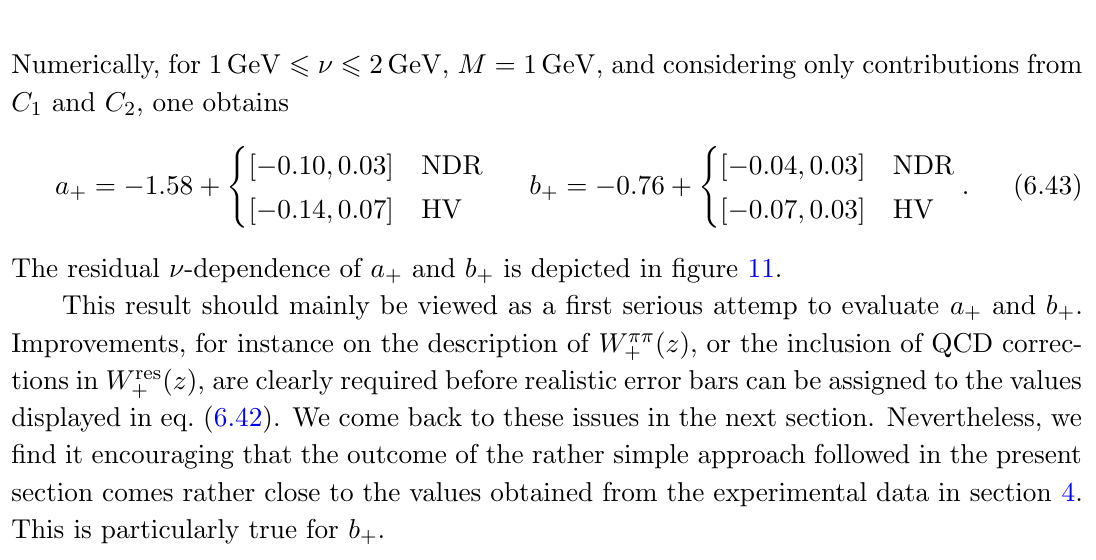
Figure 11 . The evolution of a + and b + with respect to (cid:23) in both NDR and HV schemes, for M = 1